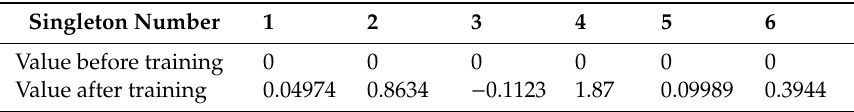
Figure 13. Membership functions before and after the learning process: ( a ) for the first input variable; ( b ) for the second input variable. Dashed lines refer to the shape of the set before the training phase; solid lines refer the shape of the set after the training phase. Table 2. The values of